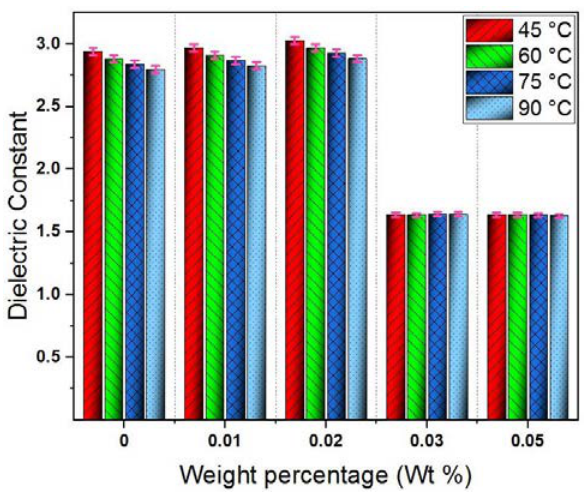
Figure 7. Dielectric constant of GO-based CSO nanofluids against weight percentage at various Figure 7. temperatures.